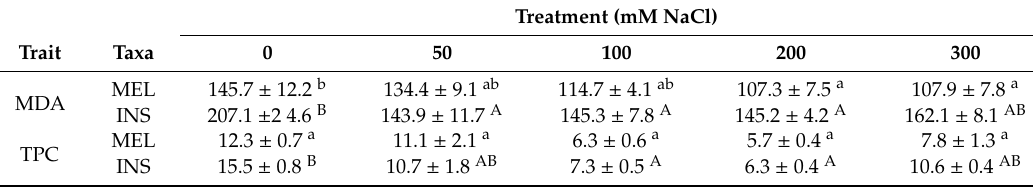
Table 5. Malondialdehyde (MDA), total phenolic compounds (TPCs), total flavonoids (TFs), and activity of the antioxidant enzymes: superoxide dismutase (SOD), catalase (CAT), and glutathione reductase (GR) in S. melongena (MEL) and S. insanum (INS) after 25 days of treatment with the indicated NaCl concentrations.